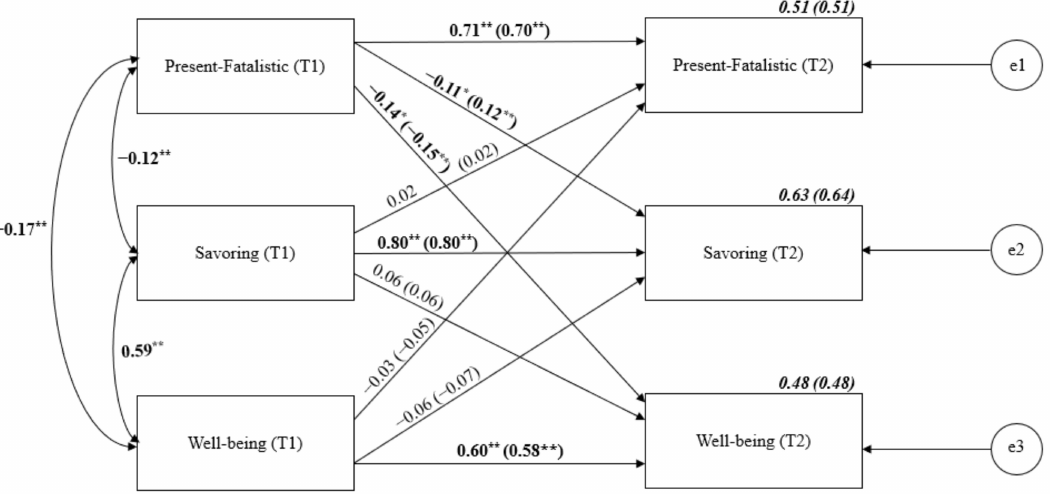
Figure 4. Cross-lagged panel analysis of Present-Fatalistic TP, savoring the moment and well-being. Notes: Path entries are standardized estimates. T1 and T2 indicate the time when data were collected (Time 1 or Time 2, respectively). Estimates for the corresponding model with age and gender controlled are given in brackets. e1–e3 refers to the residual error or error variance that causes response variation in observed variables. * p < 0.05; ** p <